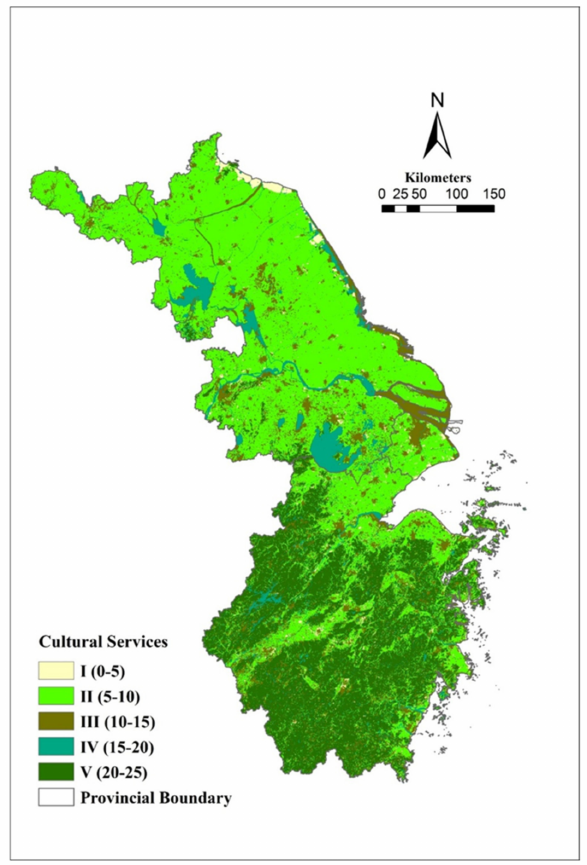
Figure 6. Spatial pattern and levels of cultural services of YRD. Level V was continuously and densely distributed in the south of the region and covered most areas of the Zhejiang Province, while Level II was densely distributed in the middle and north of the region, and covered most of the Jiangsu Province and Shanghai. Level V and Level II accounted for 27.44% and 57.64% of the total area, respectively.